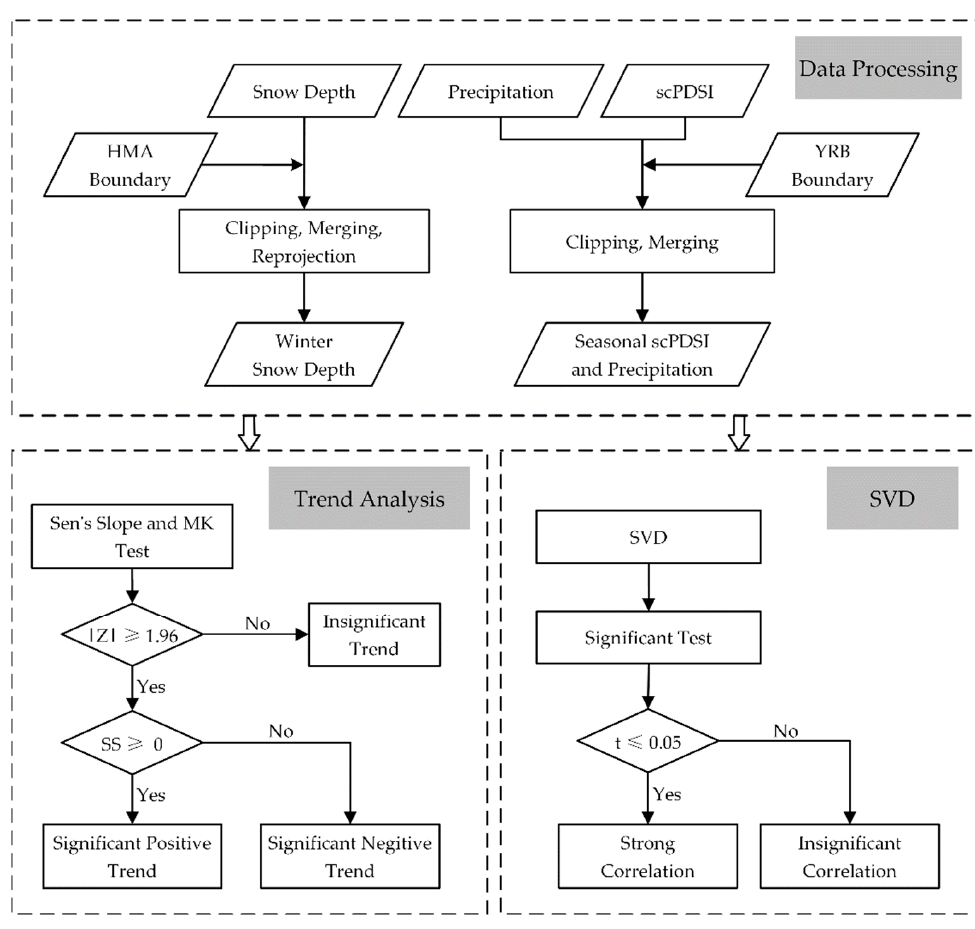
Figure 2. The research process of this paper includes three main parts: data processing, trend anal- ysis, and